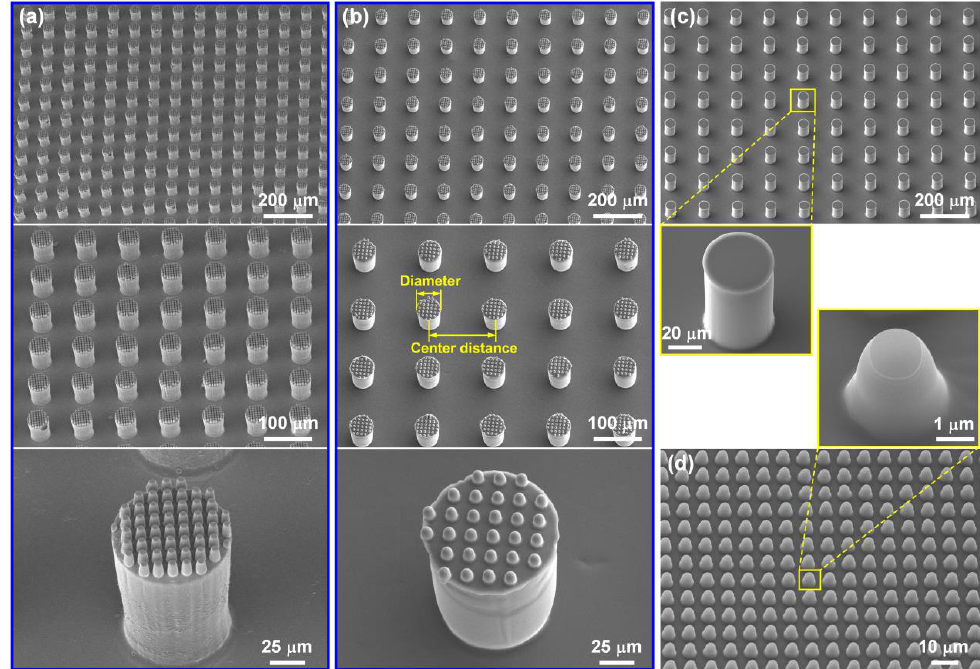
Figure 2. SEM images of the PDMS films: ( a ) hierarchical structure I-100-II-6, ( b ) hierarchical structure I-150-II-9, ( c ) individual primary structure I-150, and ( d ) individual secondary structure II-9.